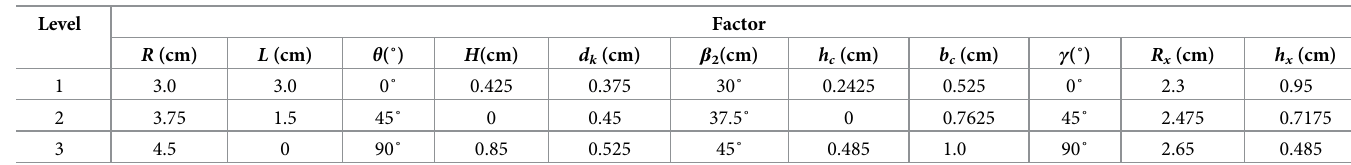
Table 3. Factor level